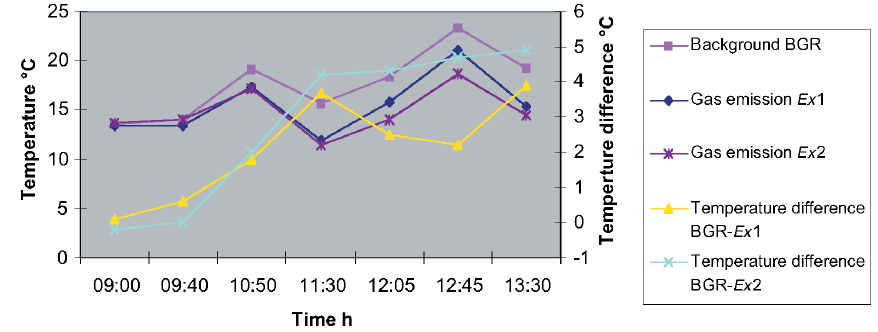
Fig. 7. Temperatures and temperature differences as function of